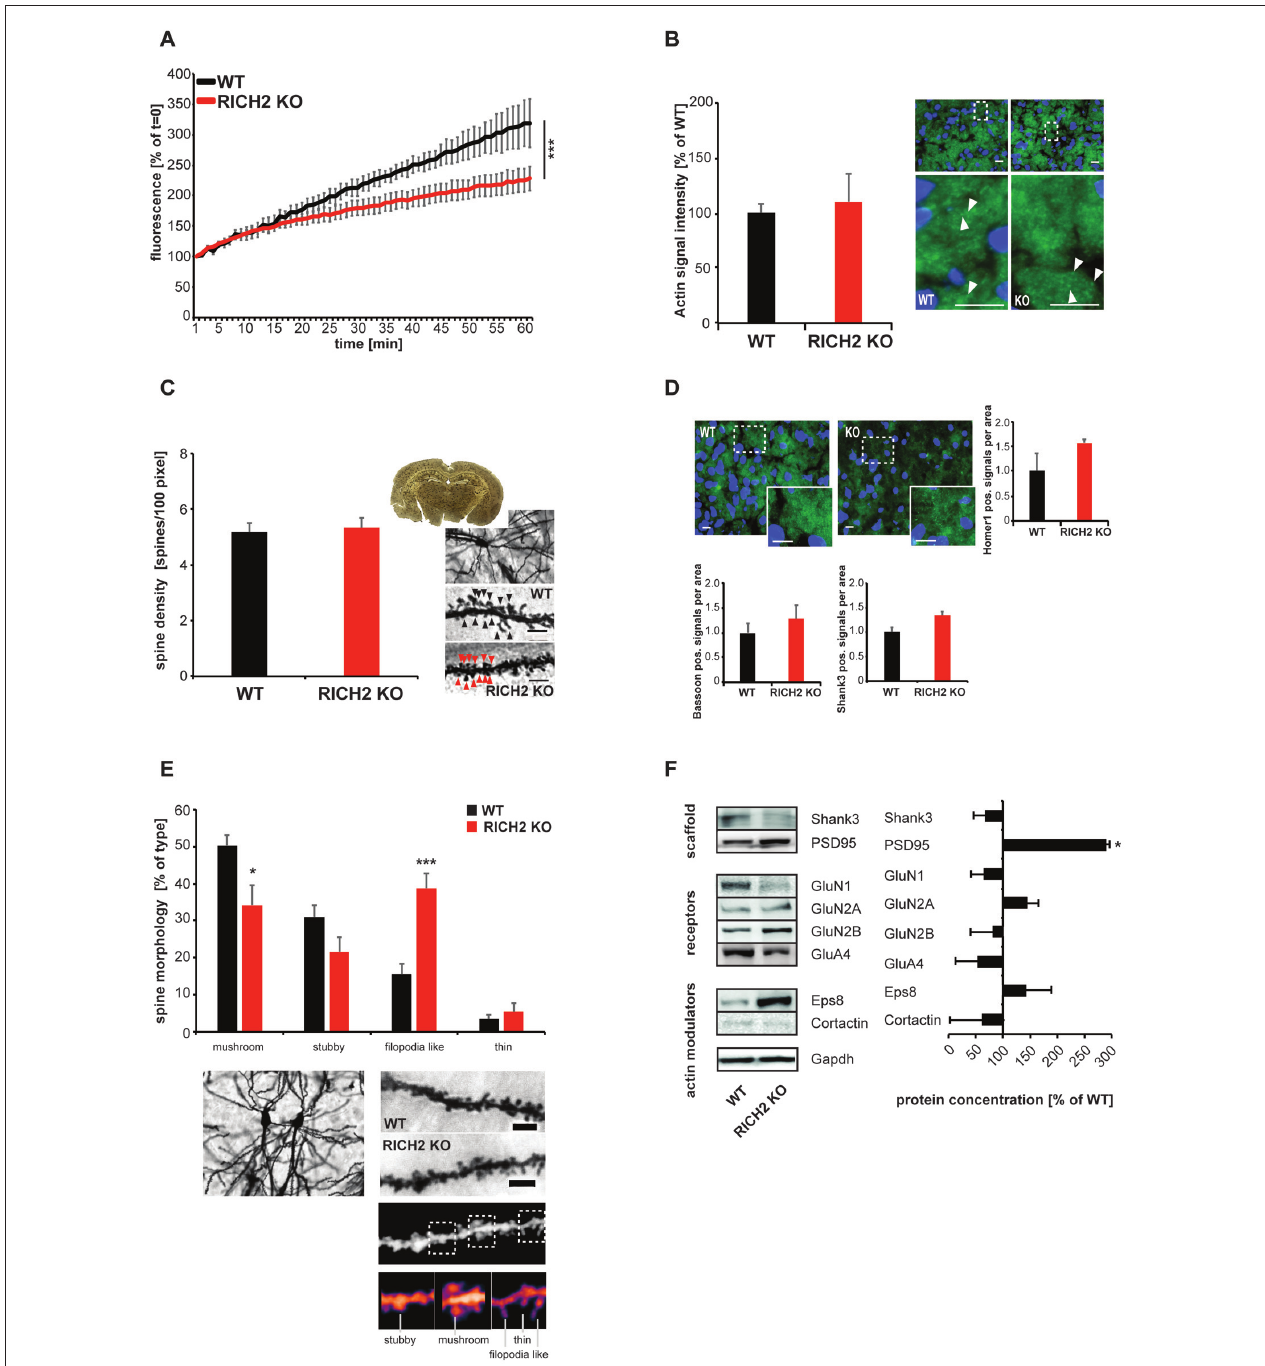
FIGURE 6 | Altered actin polymerization and spine morphology in amygdala of RICH2 KO mice. (A) Amygdala P2 lysates from WT and RICH2 KO animals ( n = 3) were used in an actin polymerization assay. The lysate was added to a solution with pyrene-conjugated actin and the increase in fluorescence intensity that occurs when pyrene G-actin (monomer) forms pyrene F-actin measured over a time-course of 60 min. P2 lysate from amygdala of RICH2 KO mice induces actin polymerization to a significantly lower amount compared to lysate from WT mice (ANOVA, F ( 1,14 ) = 537.128, p < 0.0001). (B) The amount of total actin at synapses, measured by Immunohistochemistry (IHC; arrows) in the amygdala region of mice, is not significantly different between RICH2 KO and WT mice. Scale bar = 30 µ m. (C) Spine density assessed by Golgi staining in the amygdala of mice ( n = 10), was not significantly different in RICH2 KO mice compared to WT (scale bar = 5 µ m). (D) Spine density assessed by quantification of HOMER1, SH3 and multiple ankyrin repeat domains 3 (SHANK3; postsynaptic markers) and BASSOON (presynaptic marker) positive signals per area was not significantly different in RICH2 KO mice compared to WT. Exemplary images show DAPI staining of nuceli (blue)